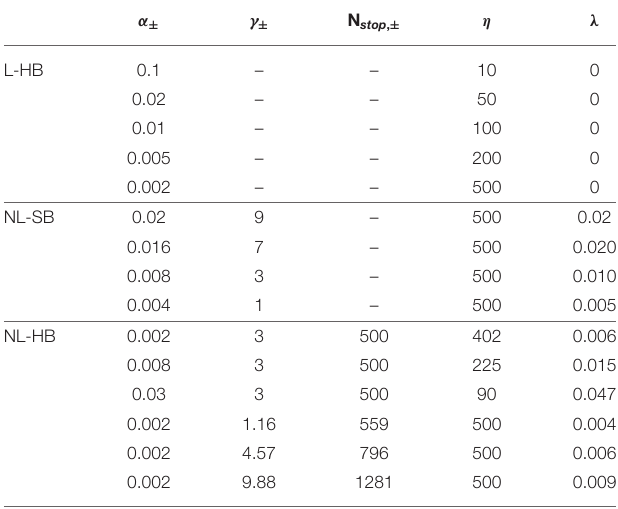
TABLE 1 | List of the investigated dynamics defined by the values of their parameters α , γ , and N stop